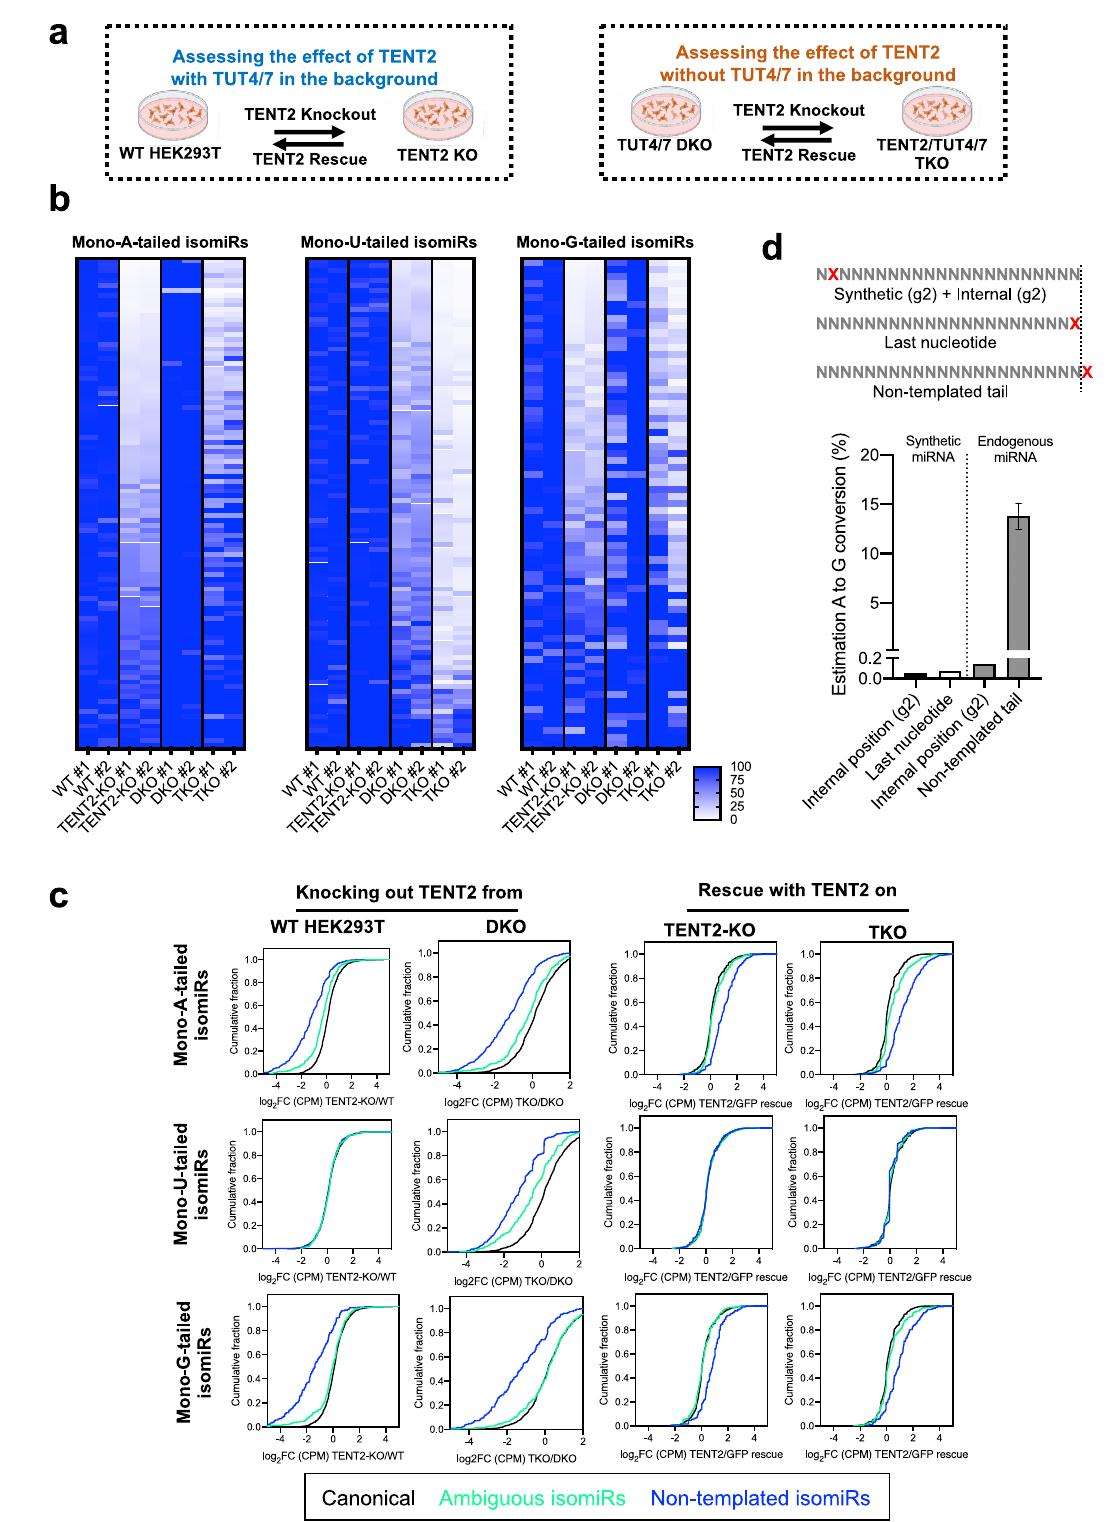
Fig. 3 | TENT2 contributes to adenylation, uridylation, and guanylation of miRNAs. a Scheme of the experimental strategy. Created with BioRender.com. b Heatmaps of the relative abundance of mono-tailed isomiRs (more details in Supplementary Fig. 3b) between WT and knockout cells.Colorimetric scale ranges invaluesbetween0and ≥ 100. c Cumulativecurvesofallmono-tailedisomiRsupon knockout or rescue of TENT2 in different cellular knockout backgrounds. Colored